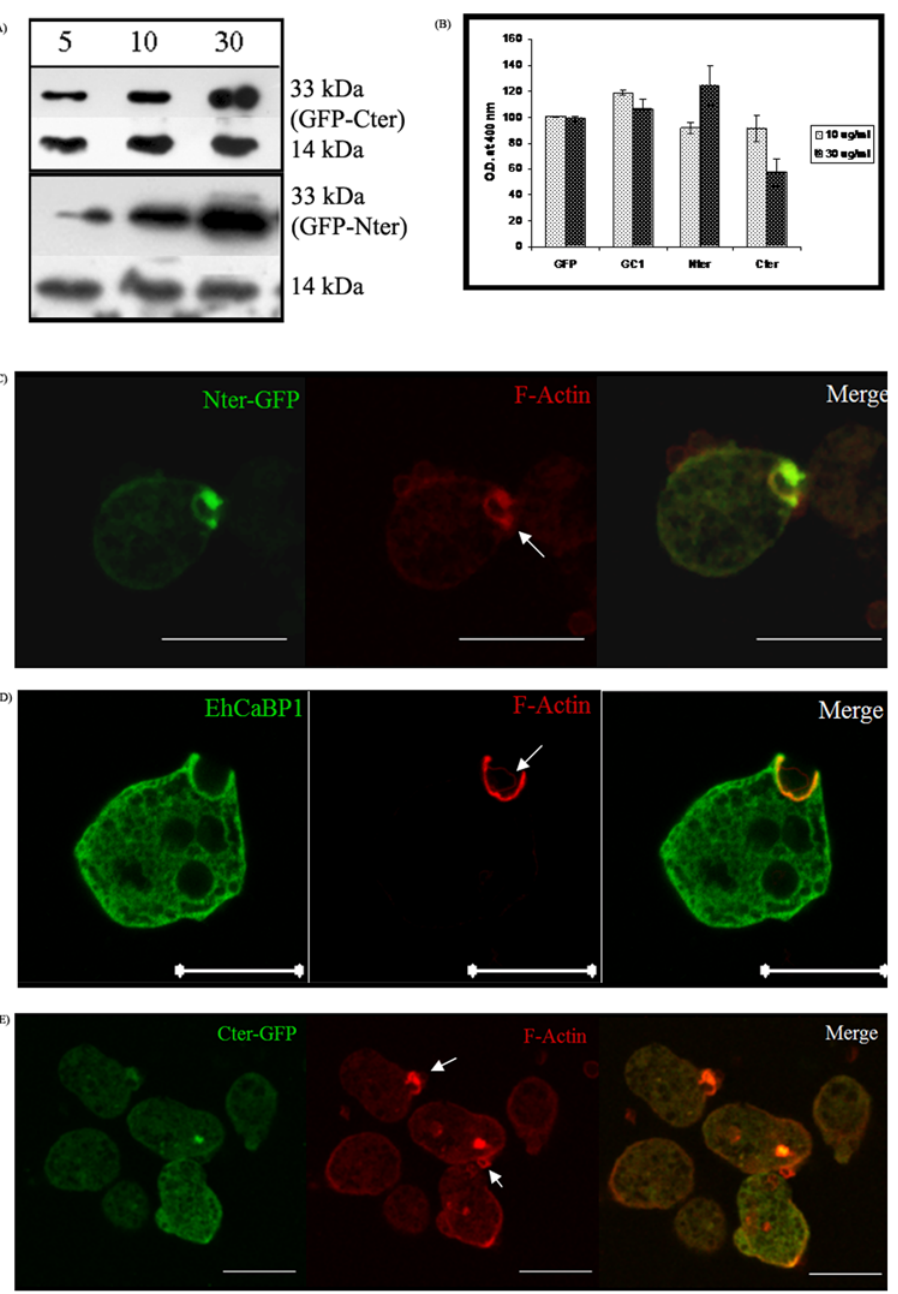
Figure 5. Expression and localization of GFP tagged EhCaBP1 domains in Entamoeba trophozoites. (A) Immunoblot analysis of the lysates prepared from cells over-expressing GFP tagged Cter or Nter domains of EhCaBP1grown at 5, 10, 30 m g/ml G418. Fifty microgram of whole cell lysate is resolved on a 12% SDS-PAGE and blotted on to a nitrocellulose membrane. The blots were probed with anti-EhCaBP1 (1:2000) followed by anti-Rabbit HRPO (1:10000) and visualized using chemiluminescence substrate. (B) Erythrophagocytosis in cells over-expressing EhCaBP1 domains. The cells expressing Nter-GFP, Cter-GFP, GFP-EhCaBP1 (GC1) or vector alone (GFP) are grown at 10 m g/ml and 30 m g/ml of G418. Erythrophagocytosis is measured after incubating 10 5 amoebae with 10 7 RBC for 20 min at 37 u C. The histogram shows relative mean optical density 6 s.d of three independent experiments. (C–E) Nter (C), WT HM1:IMSS (D) and Cter (E) was visualized during erythrophagocytosis by immunolocalization in cells expressing Nter-GFP (C) or Cter-GFP (E) at 30 m g/ml G418. EhCaBP1 domains are stained with anti-GFP antibody (green) and phalloidin (red) and viewed using CSLM. Full length EhCaBP1 (D) is stained with a polyclonal antibody against EhCaBP1. Arrows indicate position of some of the RBCs. Scale bars represents 20 m m. with Ile 8, Phe 24, Val 21 and Val25 residues of EF hand motif 1 of bic pocket formed at the interface between EF1 and EF2 in the assembled domain is bound to Phe (Figure 6B) with good electron one molecule and Tyr 61, Phe 60, Phe 57, Ile 40 and Leu 37 residues density (Figure 6C). The Phe forms several hydrophobic interactions of EF hand motif 2 of another molecule (Figure 6C).